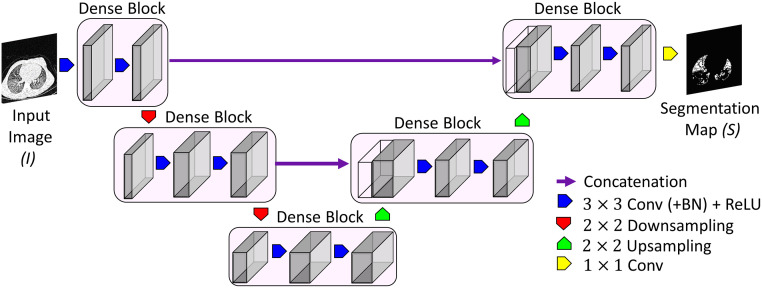
Schematic overview of the proposed dense convolutional network (DN) architecture.